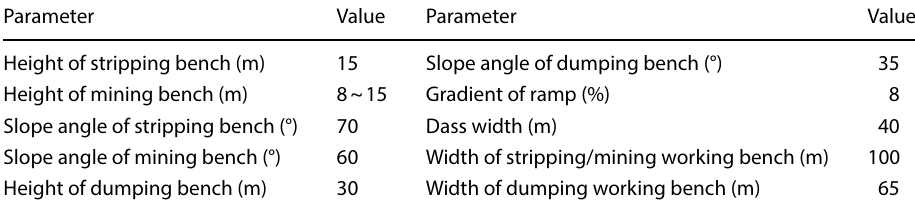
Table 1 Technical parameters Parameter Value Parameter of Antaibao open-pit coal mine Height of stripping bench